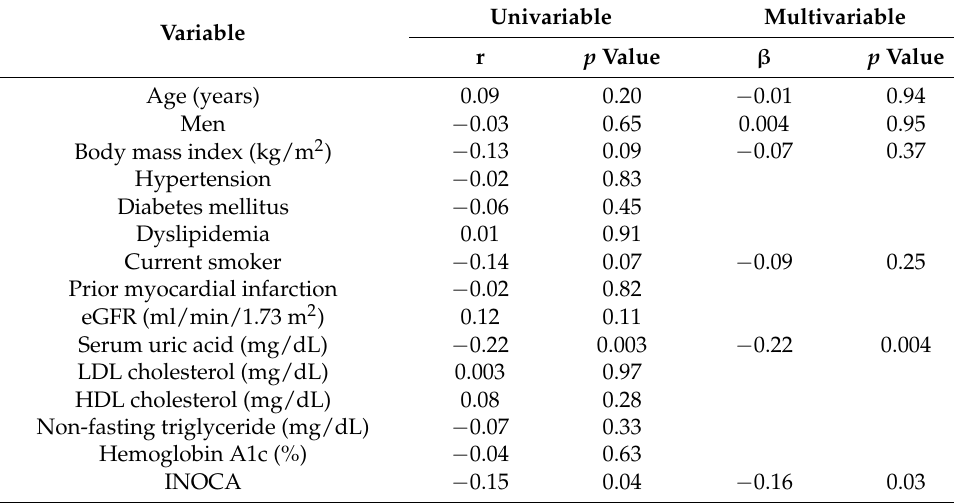
Table 2. Predictors of reactive hyperemia index.